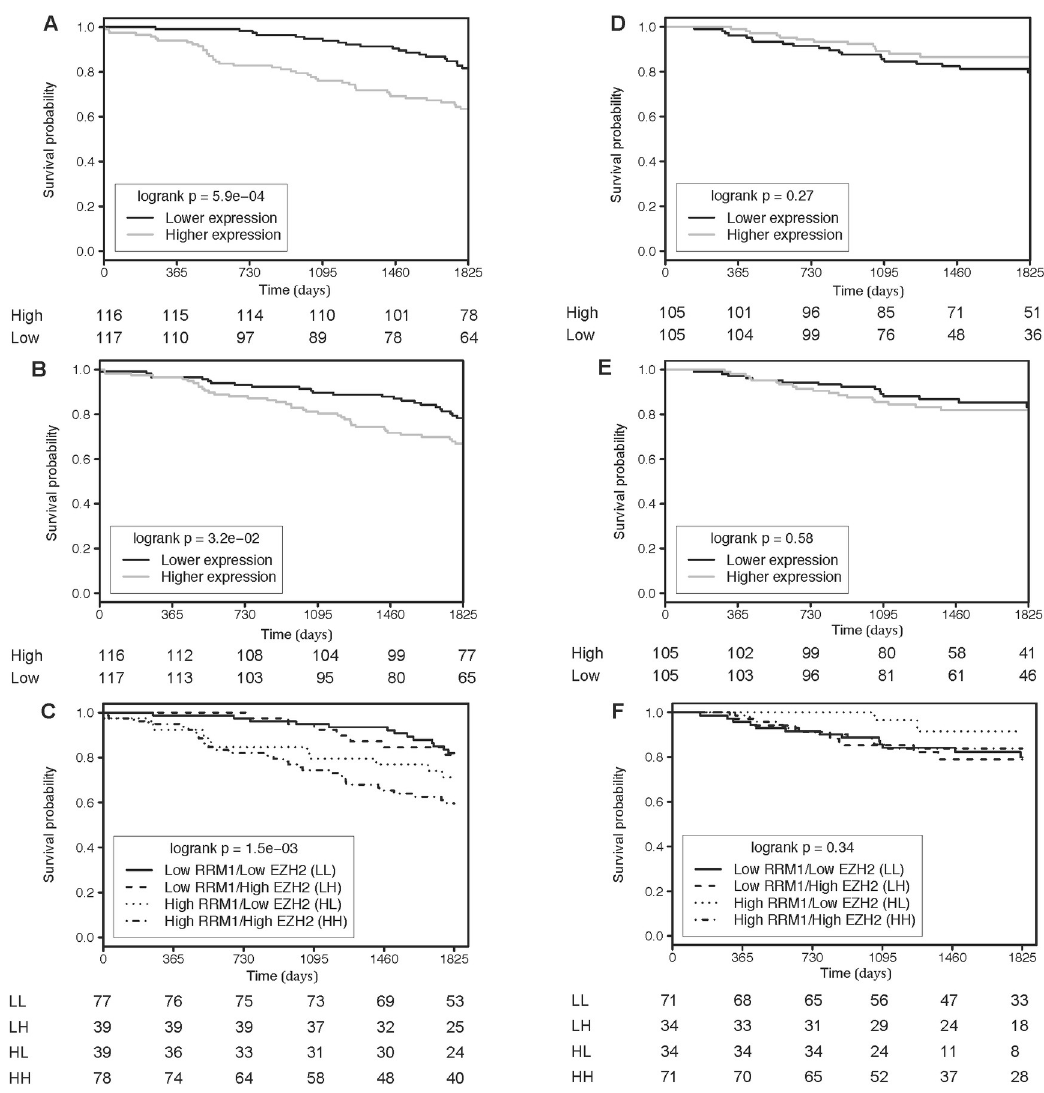
Fig 3. Kaplan-Meier analysis of overall survival in the validation set 1 according to median-derived risk categories for RRM1 (A) and EZH2 (B) and combination of RRM1 and EZH2 (C) and in the validation set 2 for RRM1 (D), EZH2 (E) and combination of RRM1 and EZH2